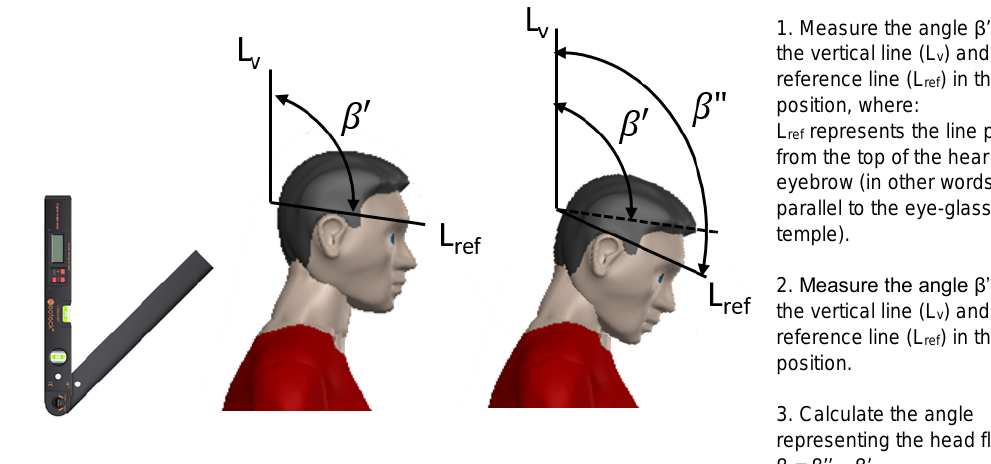
Figure 7. Practical procedure to measure head flexion.